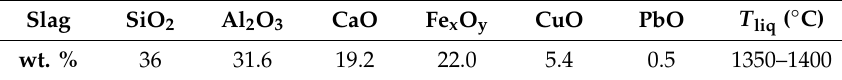
Table 3. Average composition and liquid temperature of the slag.